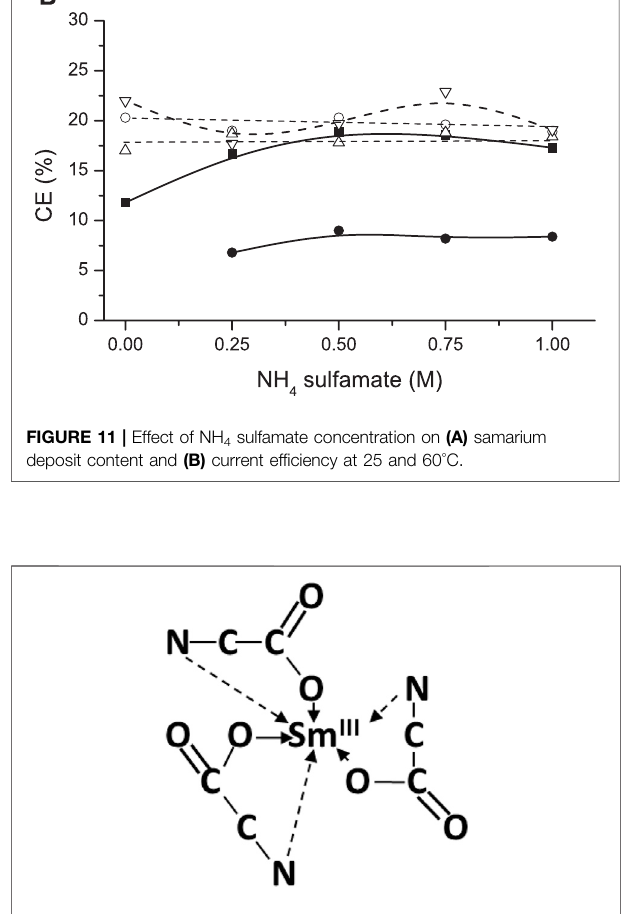
Frontiers in Chemistry |